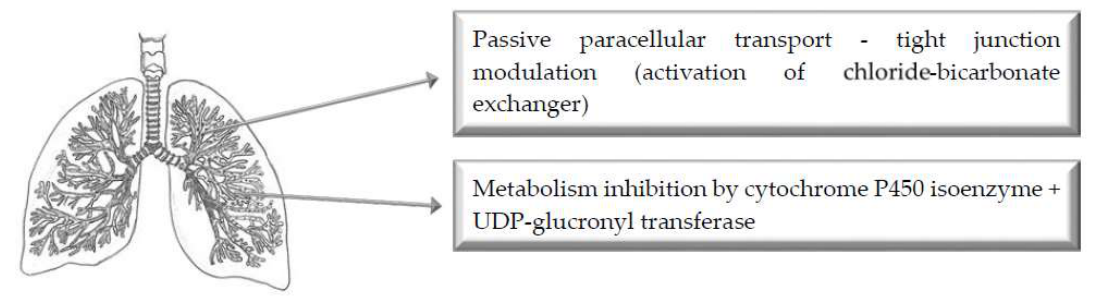
Figure 4. Illustration of the main mechanisms of action of bioenhancers for enhanced pulmonary drug